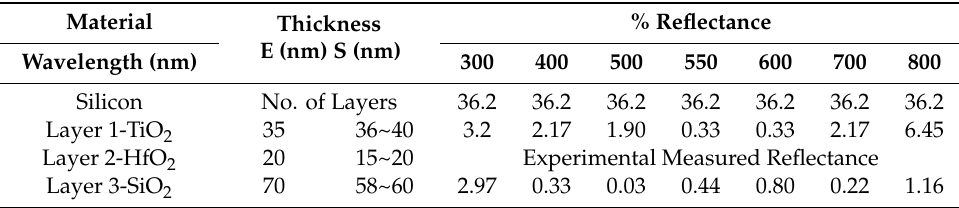
Table 3. Measured and simulated AR e ffi ciencies of trilayer AR